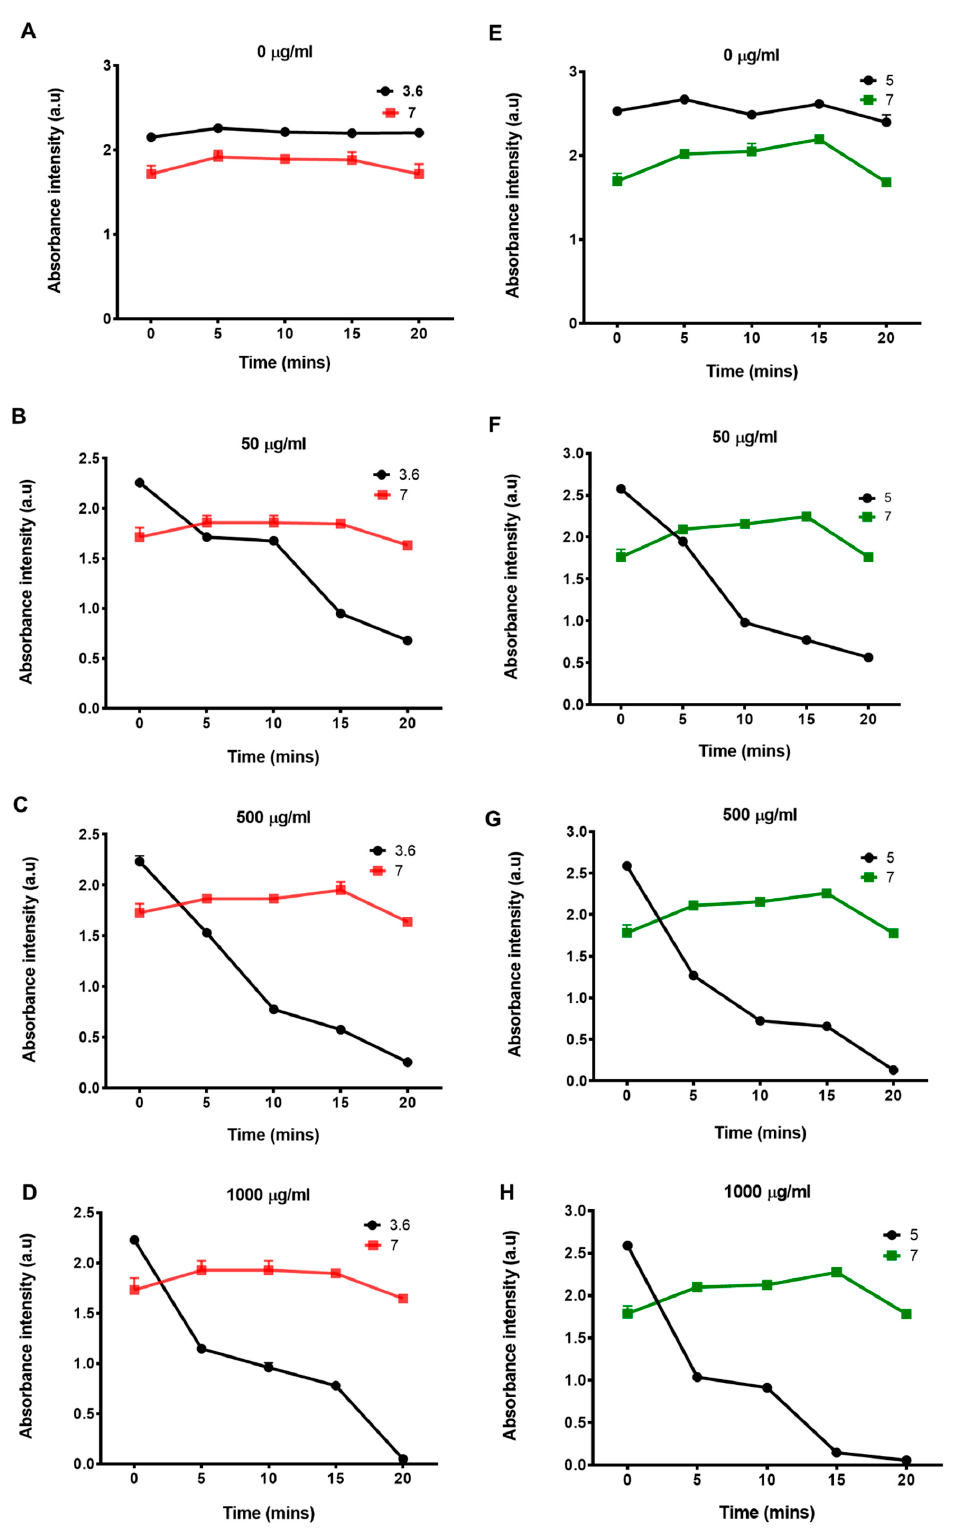
Figure 4. Effect of various concentrations of GO on CathD and CathL activities. Absorption of CathD ( A – D ) and CathL ( E – H ) by GO at different concentrations (50, 500, and 1000 µ g/mL) incubated for 2, 5, 10, 15, and 20 min. Absorbance signals were measured using a PHERAstar BMG plate reader at λ = 280 nm. Each data point represents n = 4 experiments. The horizontal bars represent SDs. For some data points, the error bar is smaller than the diameter of the data